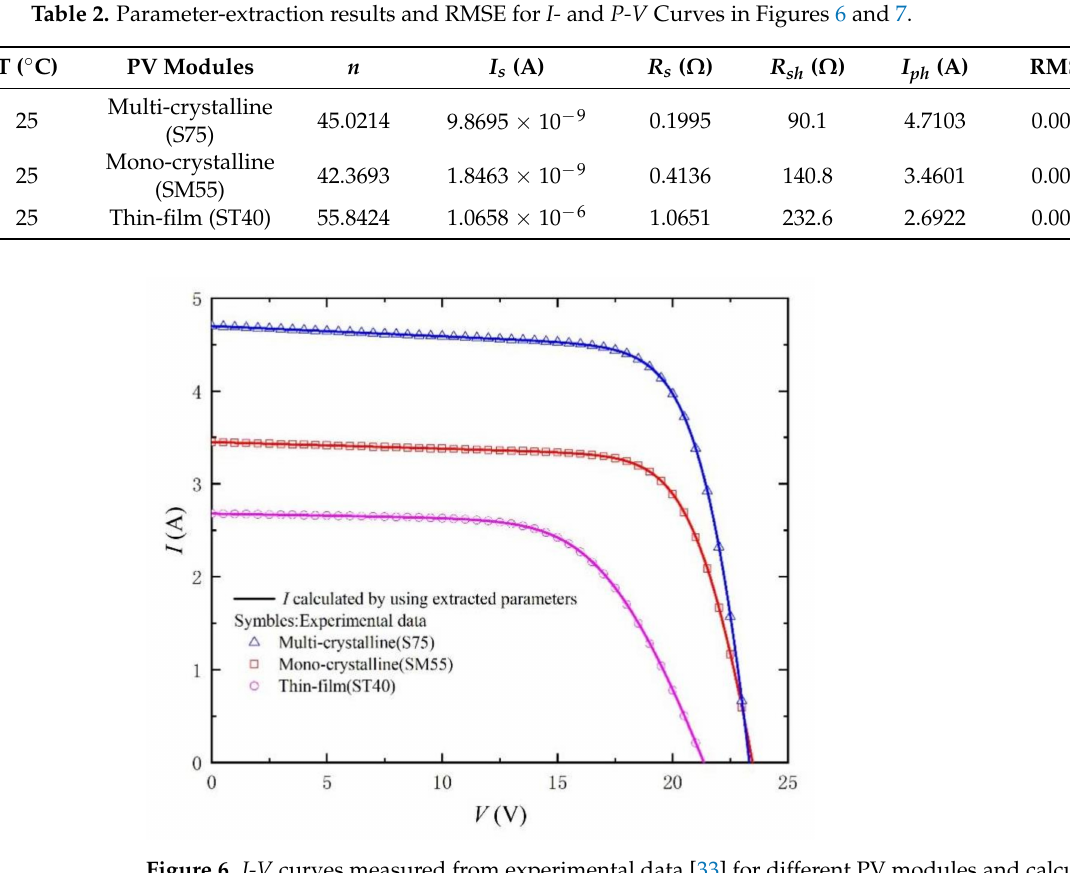
Figure 6. I-V curves measured from experimental data [33] for different PV modules and calculated by using the extracted parameters listed in Table 2.